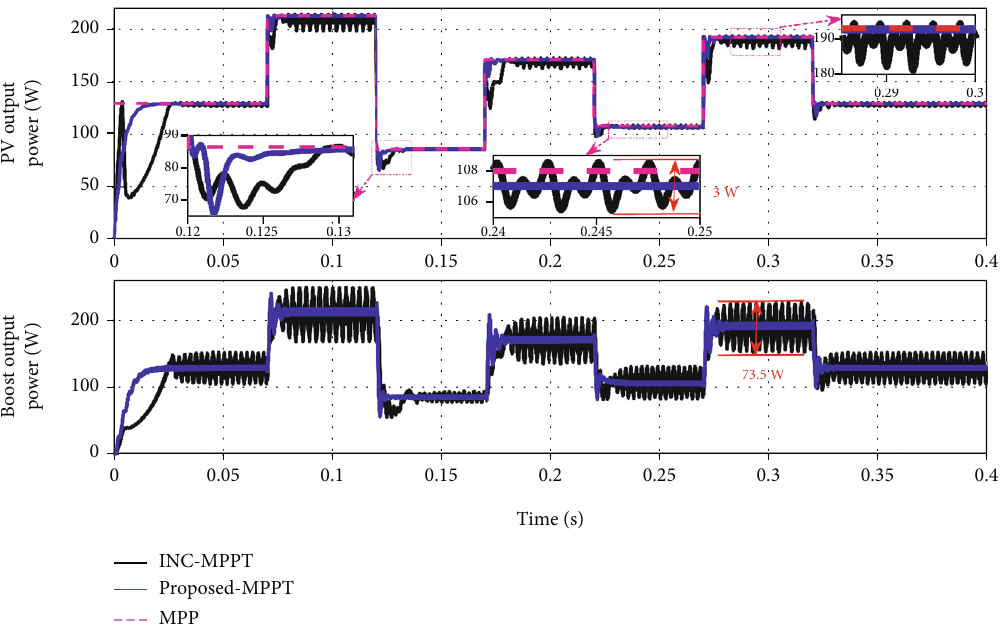
Figure 12: Comparison of the simulation results of the output PV and boost converter power.